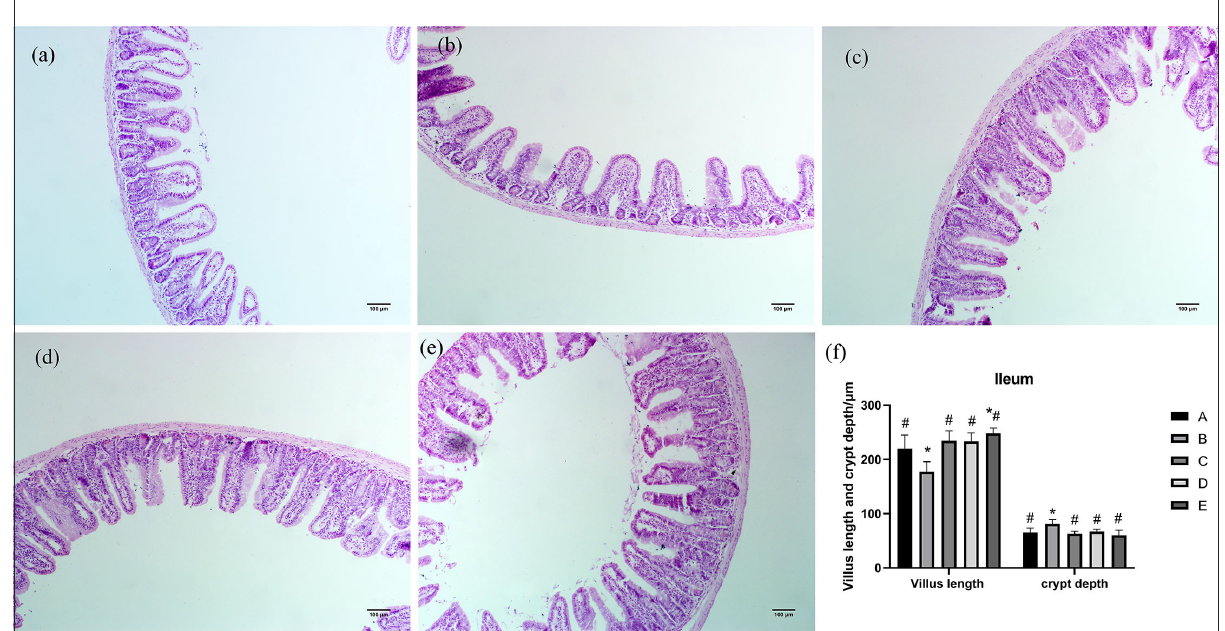
FIGURE2 Effects of CSPCM on the morphological features of jejunum. (a) Morphological observation of jejunum in group A. (b) Morphological observation of jejunum in group B. (c) Morphological observation of jejunum in group C. (d) Morphological observation of jejunum in group D. (e) Morphological observation of jejunum in group E. (f) Effect of CSPCM on jejunum villus length and crypt depth. * Significant difference with group A ( P < 0.05). # Significant difference with group B ( P < 0.05).